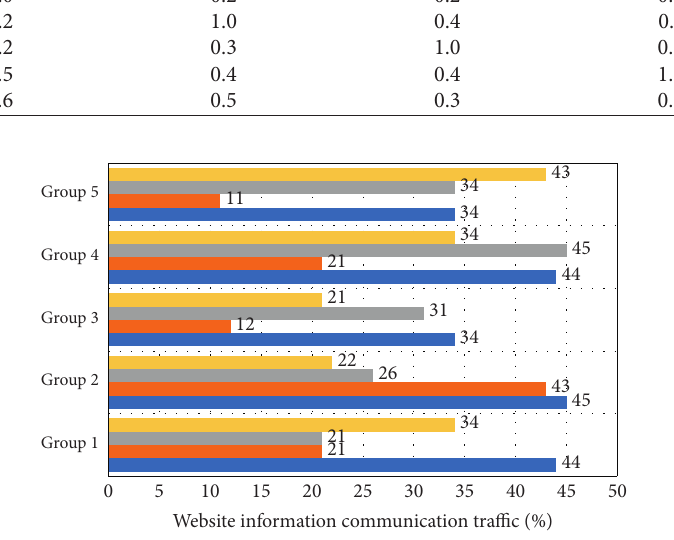
Figure 6: Distribution of information and communication traffic on the website.